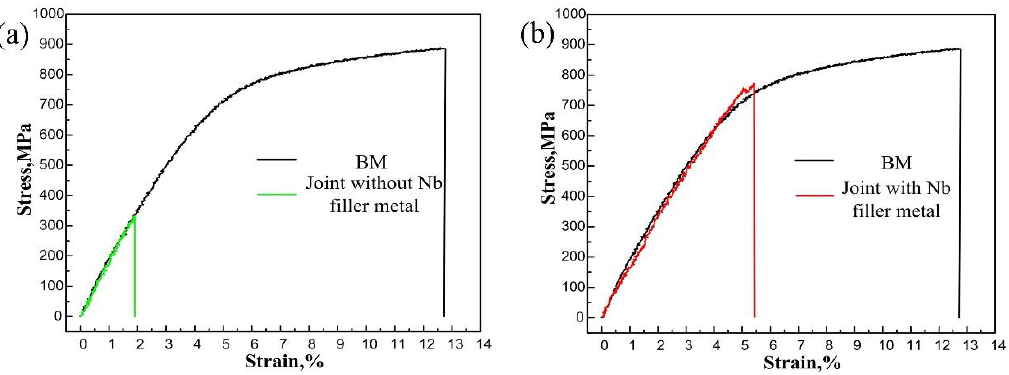
Figure 11. Stress-strain curves of the base metal (BM) and laser-welded joints without filler metal ( a ) and with Nb filler metal ( b ).